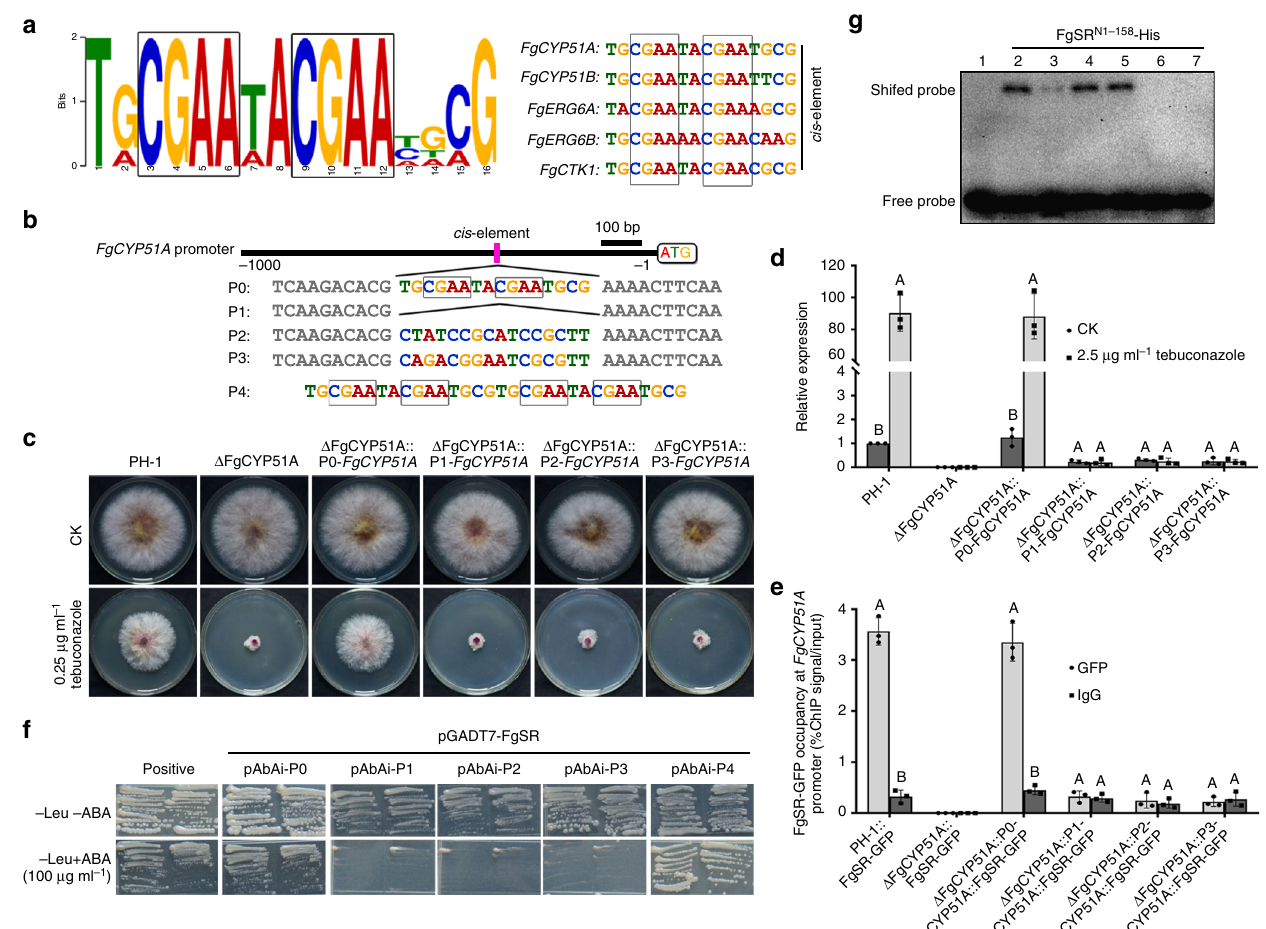
Fig. 7 Identi fi cation of cis -element of FgSR in F. graminearum . a The putative sequence of the cis -element obtained by analyzing the promoters of fi ve target genes with the MEME program. Two CGAA-repeated sequences within the cis -elementare indicated by the black squares. b Schematic representation of modi fi ed cis -element in the promoter of FgCYP51A . Two CGAA-repeated sequences are indicated by the black squares. c The cis -element-deleted ( Δ FgCYP51A::P1-FgCYP51A) or -mutated ( Δ FgCYP51A::P2-FgCYP51A and Δ FgCYP51A::P3-FgCYP51A) strains displayed increased sensitivity to tebuconazole. d In the strains Δ FgCYP51A::P1-FgCYP51A, Δ FgCYP51A::P2-FgCYP51A, and Δ FgCYP51A::P3-FgCYP51A, the expression of FgCYP51A was reduced and could not be induced by the treatment with 2.5 μ g ml – 1 tebuconazole. The expression level of FgCYP51A in the wild type without treatment was set to 1. e ChIP-qPCR assay revealed that FgSR could not bind to the FgCYP51A promoter lacking the cis -element or containing a mutated cis -element. ChIP- and input-DNA samples were quanti fi ed by quantitative PCR assays with the primer pair A2 indicated in Fig. 2b; rabbit IgG was used as a control. Data presented are the mean ± s.d. ( n = 3). Bars followed by the same letter are not signi fi cantly different according to a LSD test at P = 0.01. f FgSR binds to the cis -element in the FgCYP51A promoter as indicated by yeast one-hybrid (Y1H) assays.The native FgCYP51A promoter (pAbAi-P0), cis -element-deleted and mutated FgCYP51A promoters (pAbAi-P1 to -P3) or the two repeats of the cis -element (pAbAi-P4) was used as a bait, and the pGADT7-FgSR as the prey. g Veri fi cation of the binding of FgSR with the cis -element by electrophoretic mobility shift assay (EMSA). Lane 1 and 2, biotin-labeled motif of P0 (as indicated in Fig. 7b) without FgSR N1 – 158 (lane 1) or with FgSR N1 – 158 (lane 2); lane 3 – 5, biotin-labeled motif of P0 with 100 fold excess of unlabelled motif